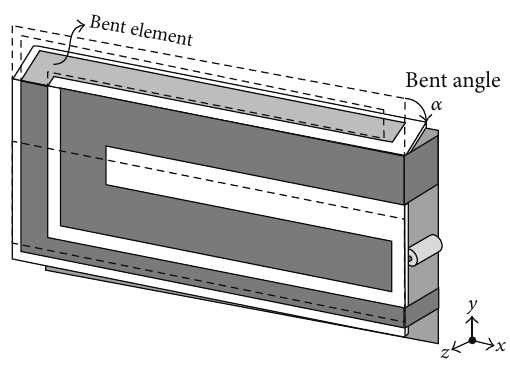
Figure 7: Direction of bending angle 𝛼 on the element.